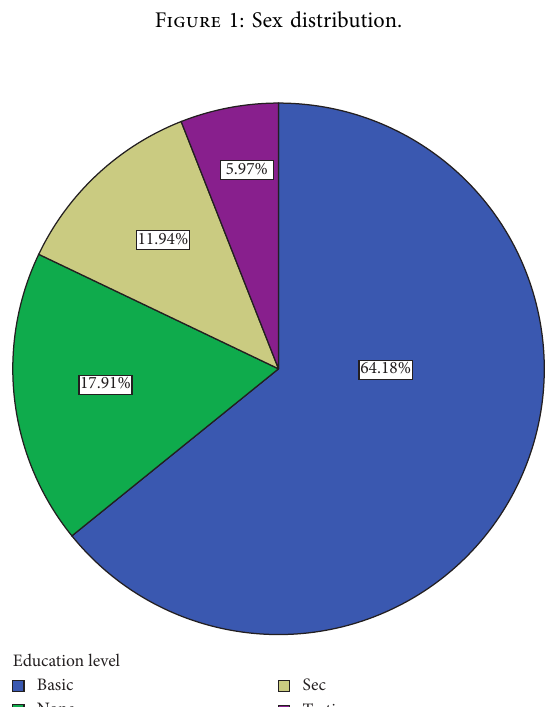
Figure 2: Distribution of educational level of participants.